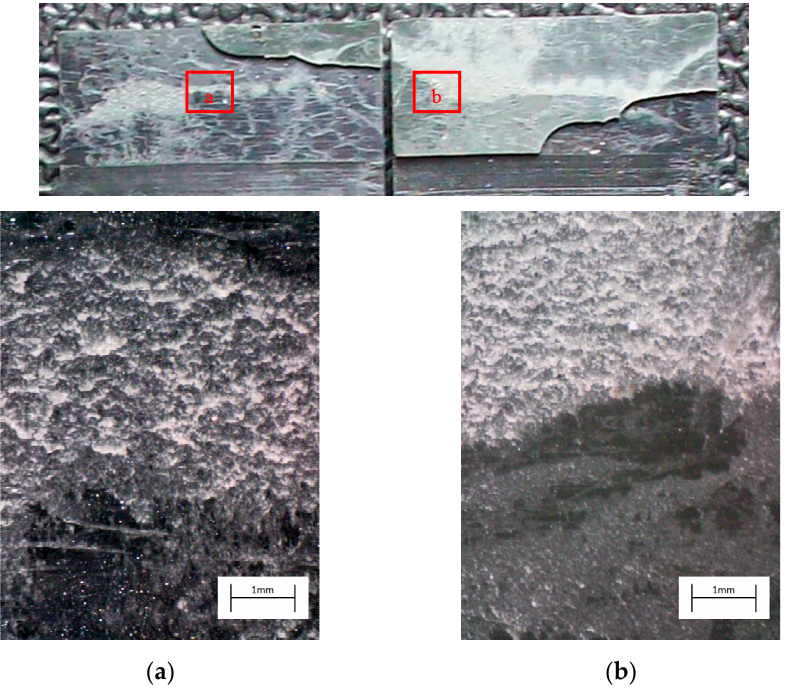
Figure 25. Fracture surface of a specimen pretreated with APPT with D = 10 mm and v = 200 mm/s and subjected to fatigue test, with magnified details ( a ) and ( b ) acquired by microscope.